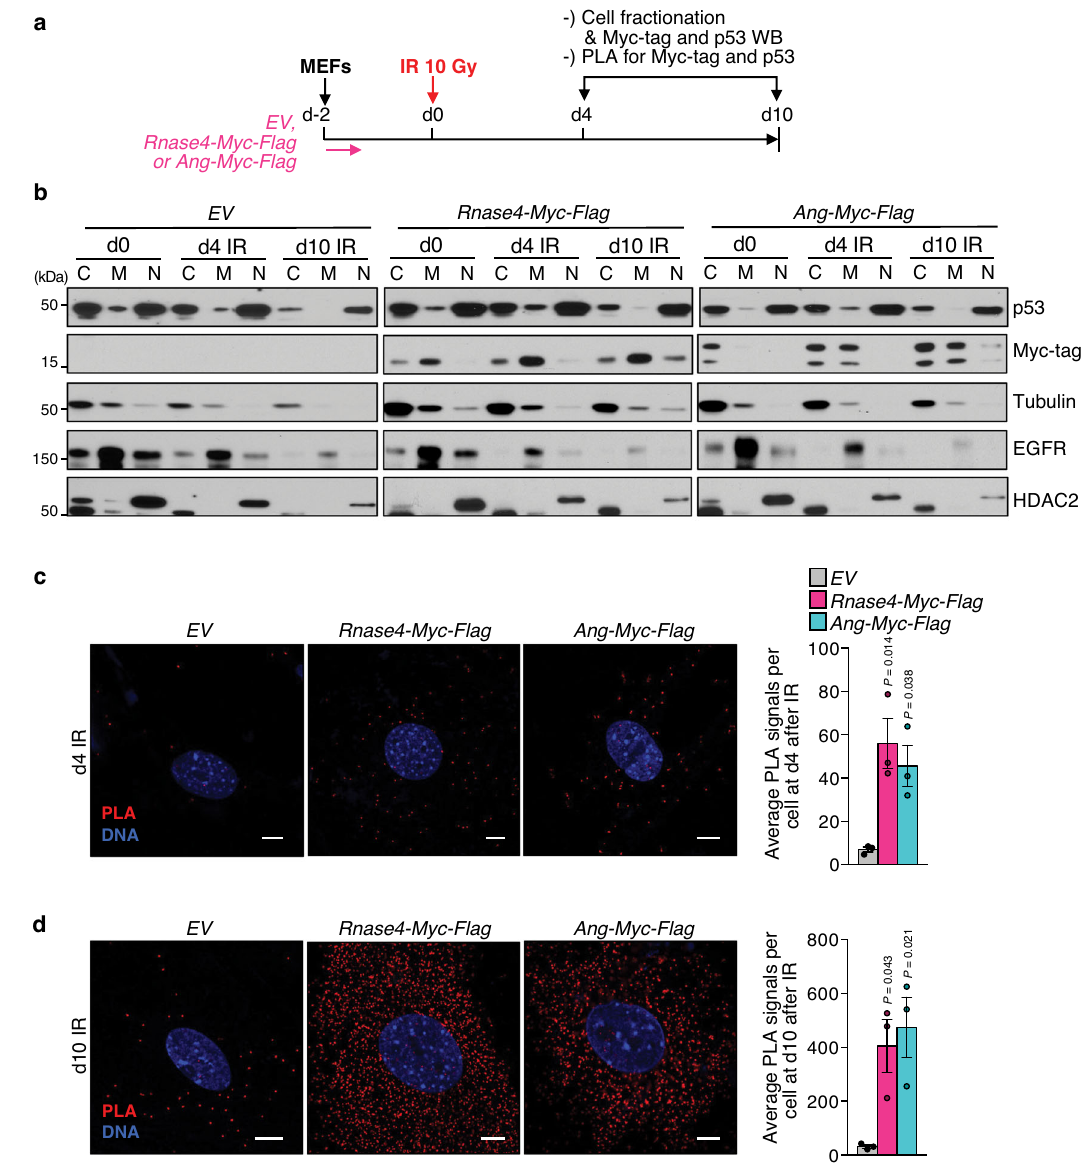
Fig. 7 RNASE4 and ANG interact with p53 in the cytoplasm in response to stress. a Experimental set-up to assess interactions between p53 and Myc- Flag-tagged RNASE4 or ANG after senescence-inducing stress. b Immunoblots of cell fractions in indicated conditions and timepoints post-irradiation. C, cytoplasmic fraction marked by Tubulin levels; M membrane fraction indicated by EGFR levels; N, nuclear fraction marked by HDAC2 levels. One experiment was performed. c , d Proximity ligation assay (PLA) on MEFs at indicated timepoints post-irradiation. PLA was assessed between endogenous p53 and Myc-Flag-tagged RNASE4 or ANG. Scale bars, 10 μ m. Data represent means± SEM. n = 3 independent MEF lines from 1 experiment in c , d